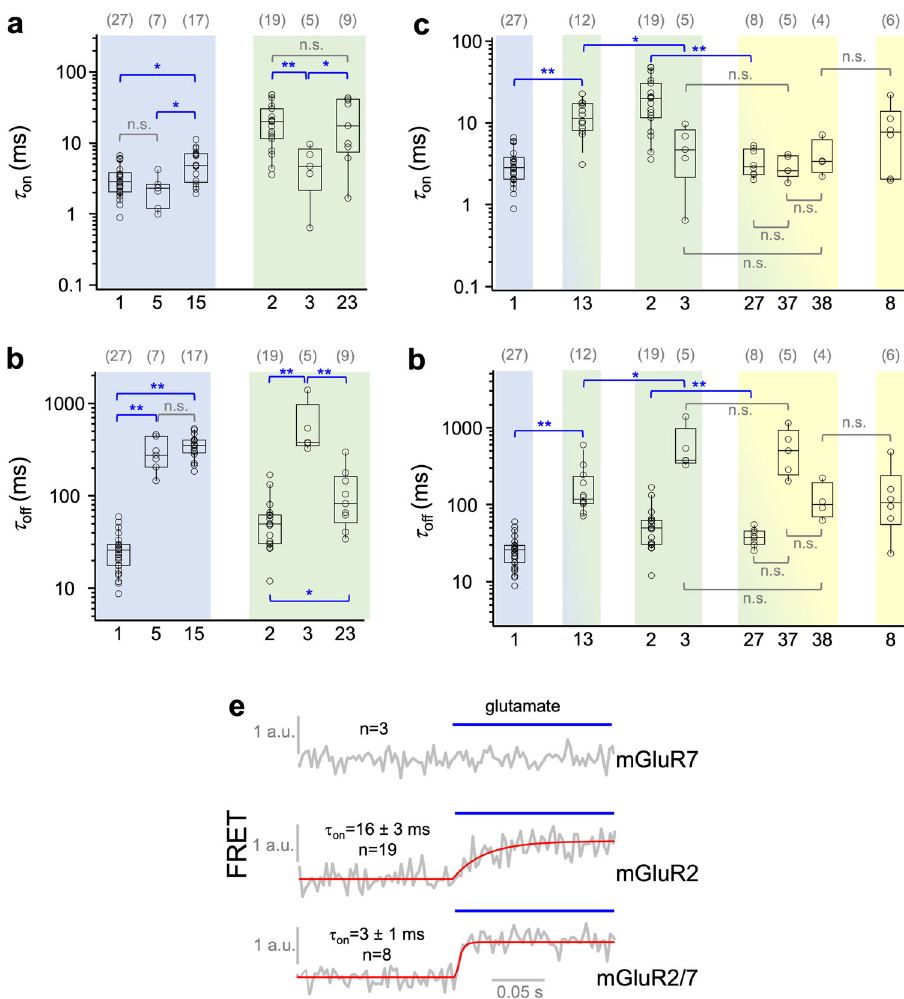
Fig. 4 Kinetic responses of heterodimeric mGluRs. a , b τ on and τ off for two heterodimers in groups I and II. c , d τ on and τ off for two heterodimers between group I and II and three heterodimers between group II and III. Homomeric data from Fig. 3 are shown for comparison. Signi fi cant differences are indicated (ANOVA followed by Turkey-Kramer posthoc test, see Methods: * p < 0.05, ** p < 0.01). The computed p -values are provided in Supplementary Table 3. n.s. indicates that the difference is ‘ not signi fi cant ’ . e Averaged time traces obtained with 1 mM glutamate for mGluR7 ( n = 3), mGluR2 ( n = 19), and mGluR2/7 ( n = 8) with fi tted exponential functions (red curves). mGluR7 is a strong accelerator in mGluR2/7 compared to mGluR2. In a – d , the numbers of experiments are shown at the top in